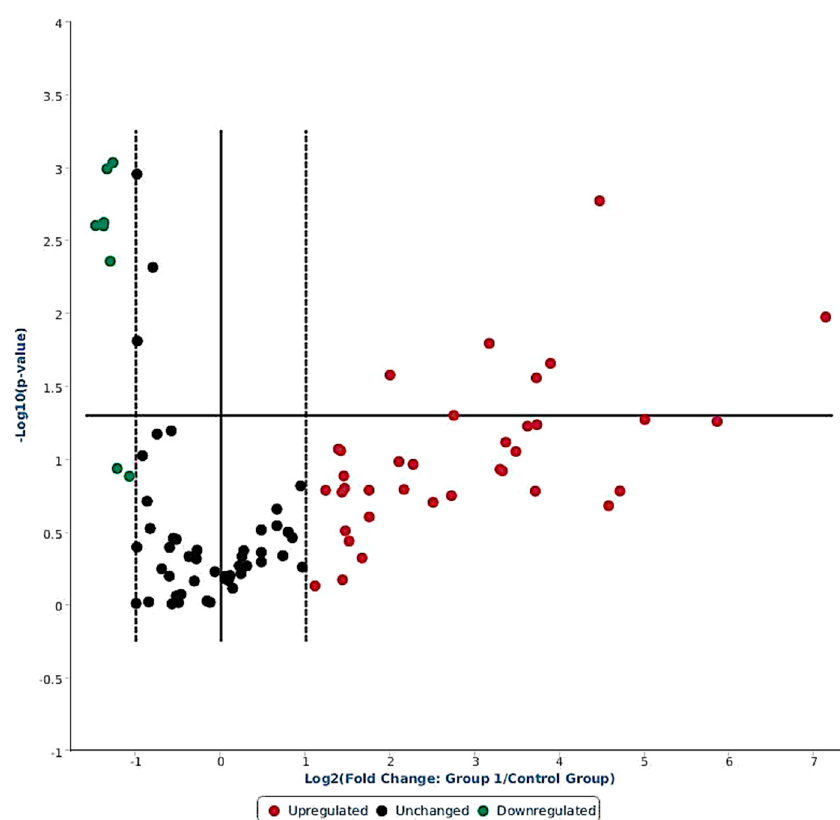
Figure 2. Volcano plot showing differential expression of 84 ovine miRNAs in response to systemic LPS challenge (4 h versus basal). The miRNAs having FR > 2 are on right hand side of the dotted line (red color), and miRNAs with FR < 1 are on left hand side of the dotted line (green color); whereas the miRNAs presented in between the two dotted lines had no change in expression (black color). Table 1. Differentially expressed ovine serum miRNA 4 h post-systemic LPS challenge. * indicates significance at p < 0.05.